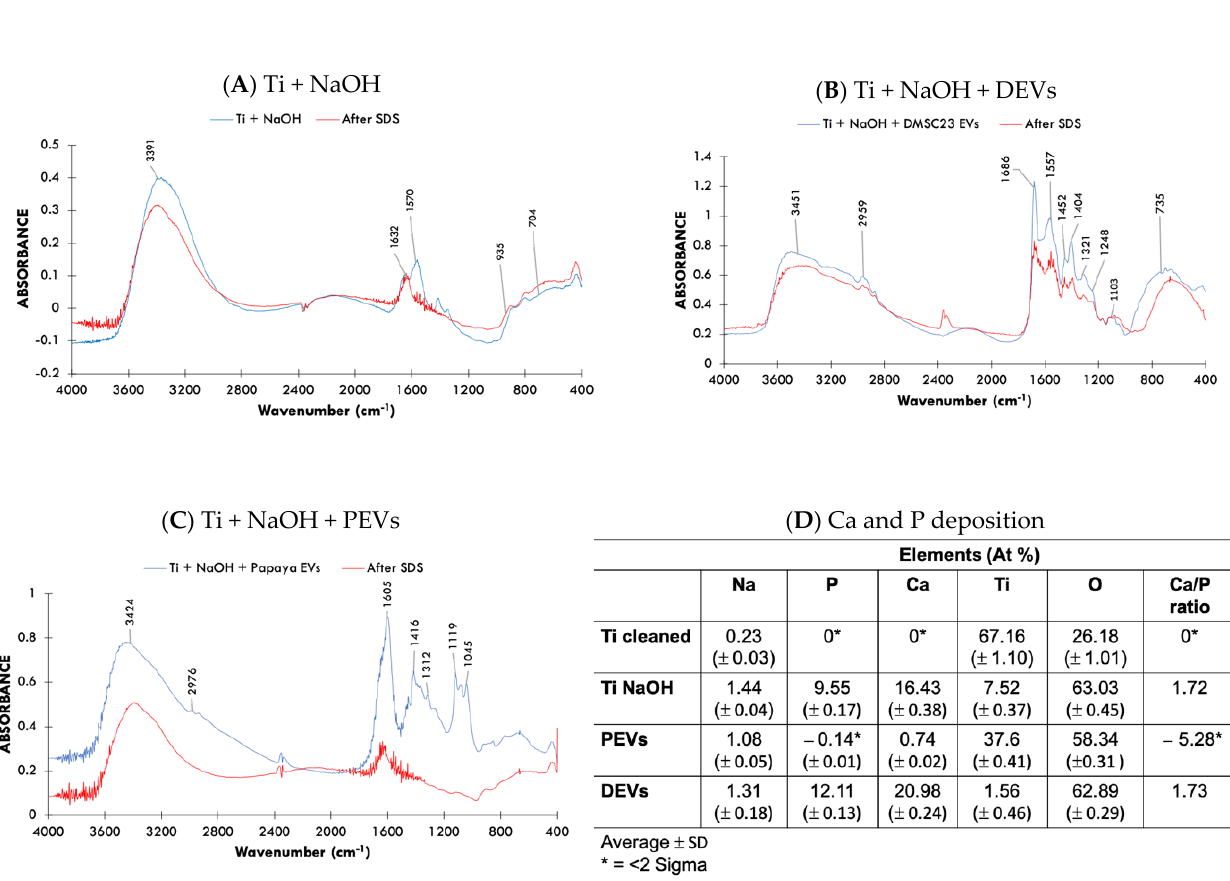
Figure 2. Physicochemical surface characterization. ( A ) FTIR spectrum of Ti + NaOH ( B ) FTIR spectrum of Ti + NaOH + DEVs ( C ) FTIR spectrum of Ti + NaOH + PEVs. ( D ) Ca and P deposition on Ti surface after 3 days in contact with SBF: (1) Cleaned; (2) NaOH; (3) NaOH + PEVs; (4) NaOH + DEVs. Results represent average of five areas ± SD values.